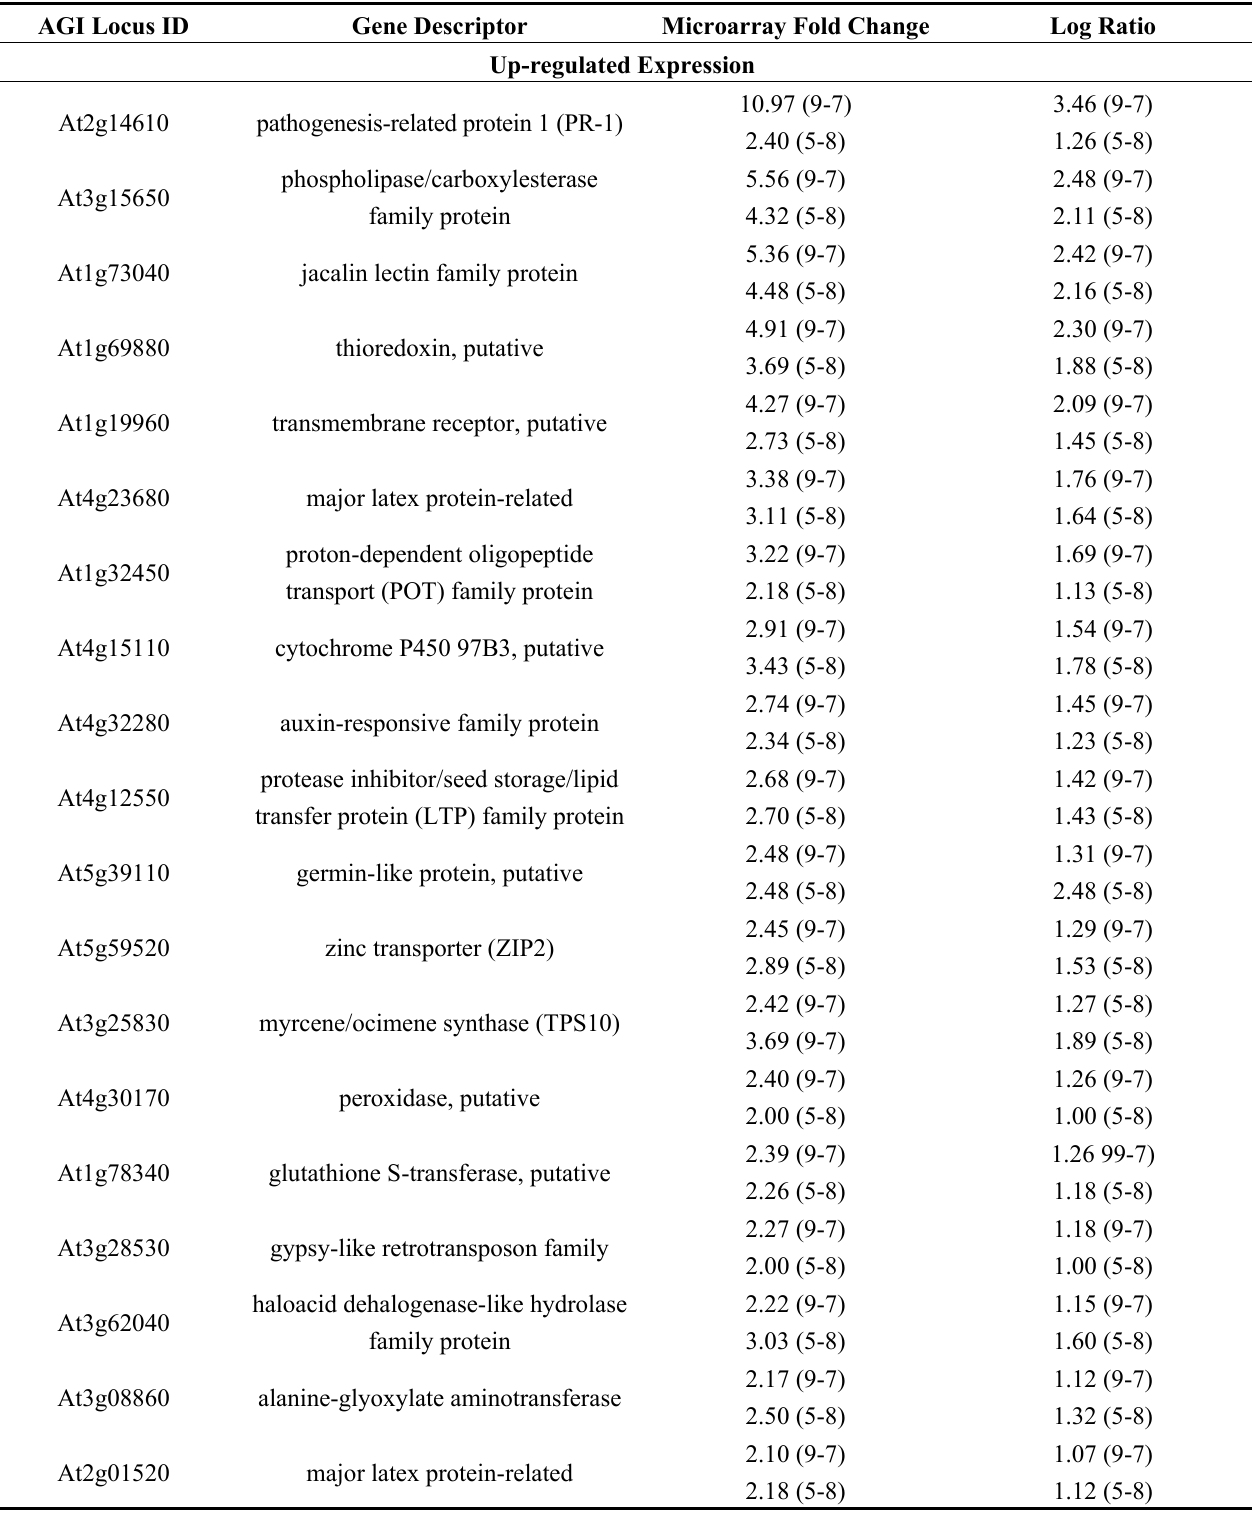
Table 3. Genes with greater than two-fold change in expression in the Hs PIPKIα 9-7 and 5-8 lines compared to WT. Notations in parentheses indicate the specific line (9-7 or